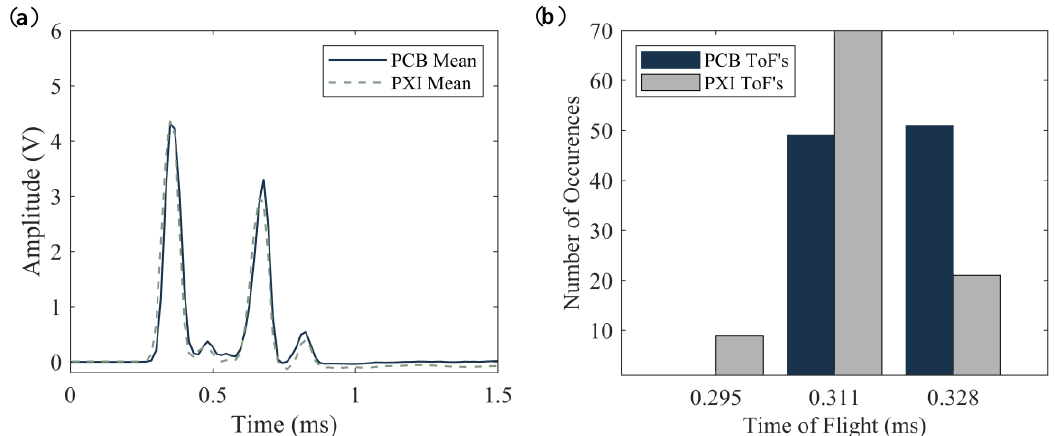
Figure 11. Steel plate test. ( a ) Time-series obtained by averaging the 100-time waveforms measured with the sensor disks. ( b ) Number of occurrences of a given ToF. For each color, the total number of occurrences is 100.